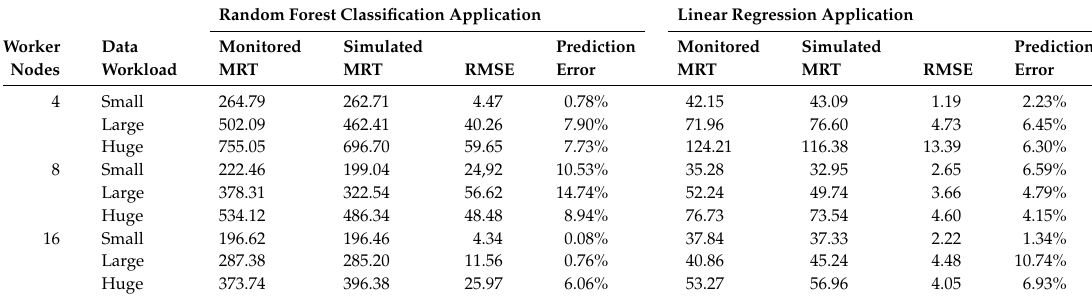
Table 4. Monitored and simulated mean response times (seconds).